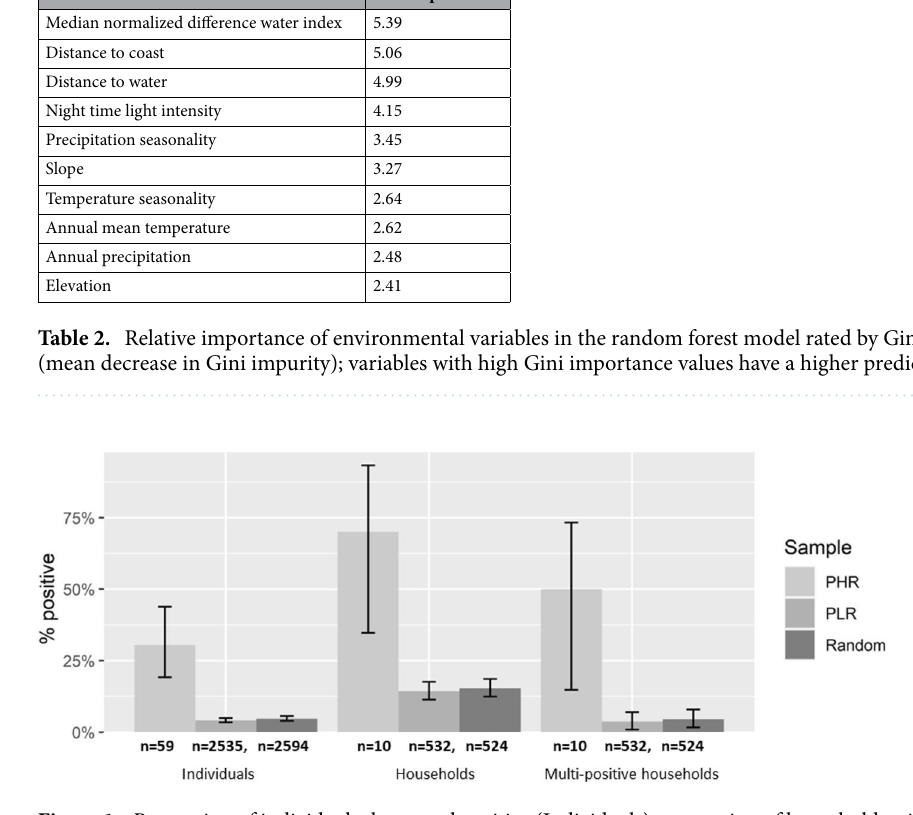
Figure 1. Proportion of individuals that tested positive (Individuals), proportion of households with at least one positive resident (Households) and proportion of households with two or more positive residents (Multi- positive households), stratified by PHR and PLR locations. The complete sample of all houses (random) is also shown. Values listed under each column indicate the total number of individuals or households in each